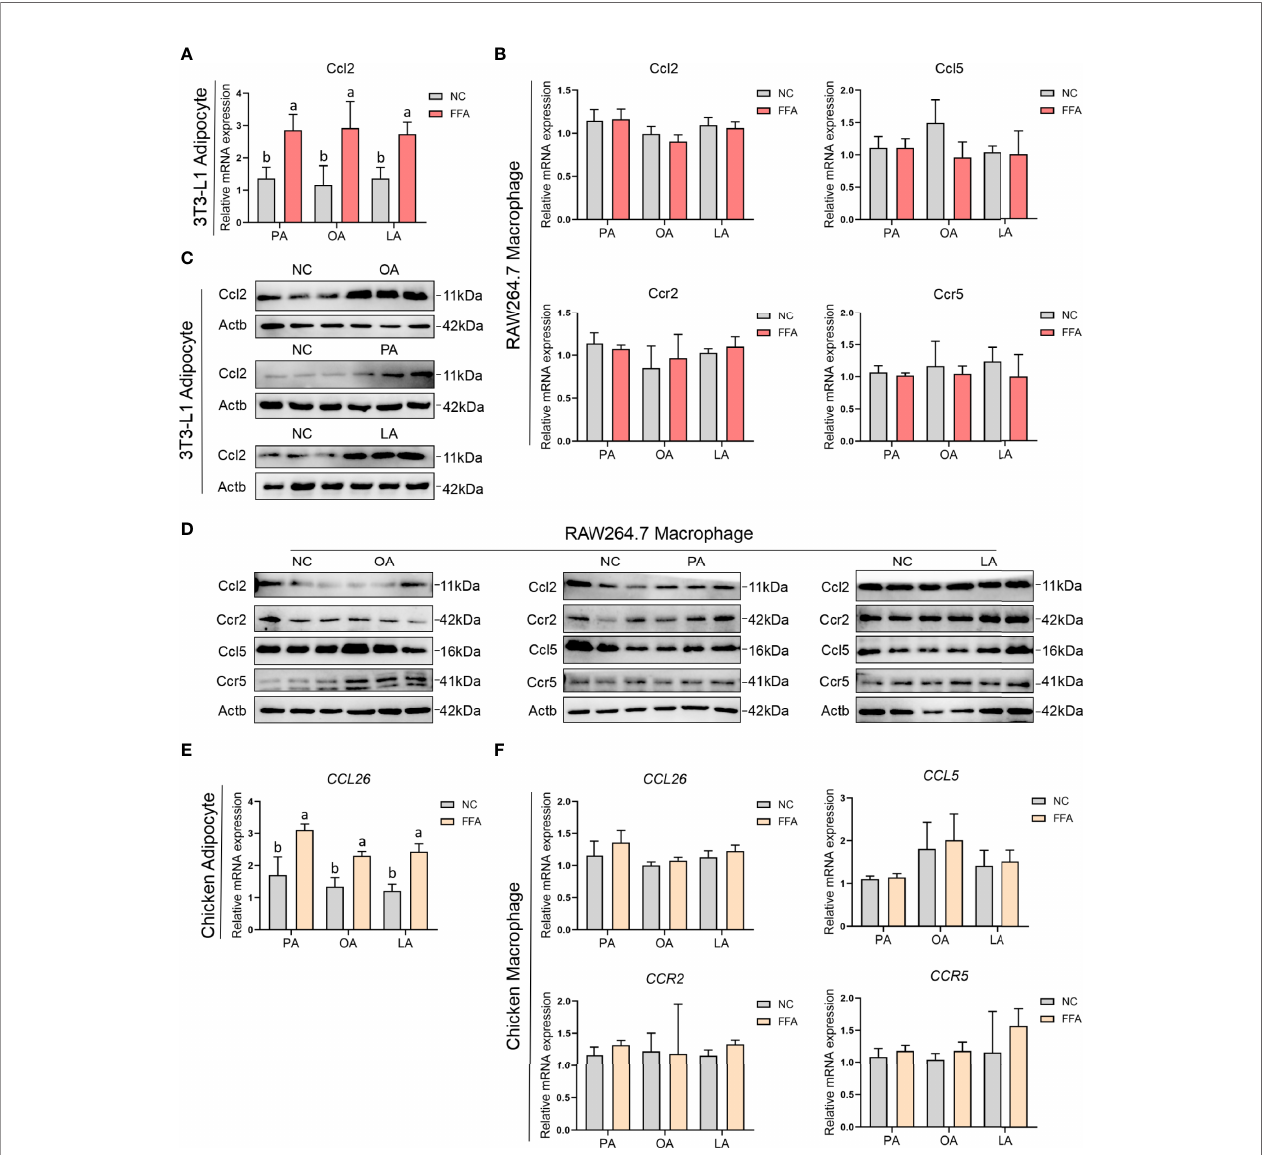
FIGURE 11 | FFA-induced adipocyte and macrophage chemokines and their receptors expression in chicken and mouse. (A) FFA-induced 3T3-L1 adipocyte Ccl2 mRNA expression; (B) FFA-induced RAW264.7 macrophage Ccl2, Ccl5, Ccr2, and Ccr5 mRNA expression; (C) FFA-induced 3T3-L1 adipocyte Ccl2 protein expression; (D) FFA-induced RAW264.7 macrophage Ccl2, Ccl5, Ccr2, and Ccr5 protein expression; (E) FFA-induced chicken adipocyte CCL26 mRNA expression; (F) FFA-induced chicken macrophage CCL26, CCL5, CCR2, and CCR5 mRNA expression. a,b= p